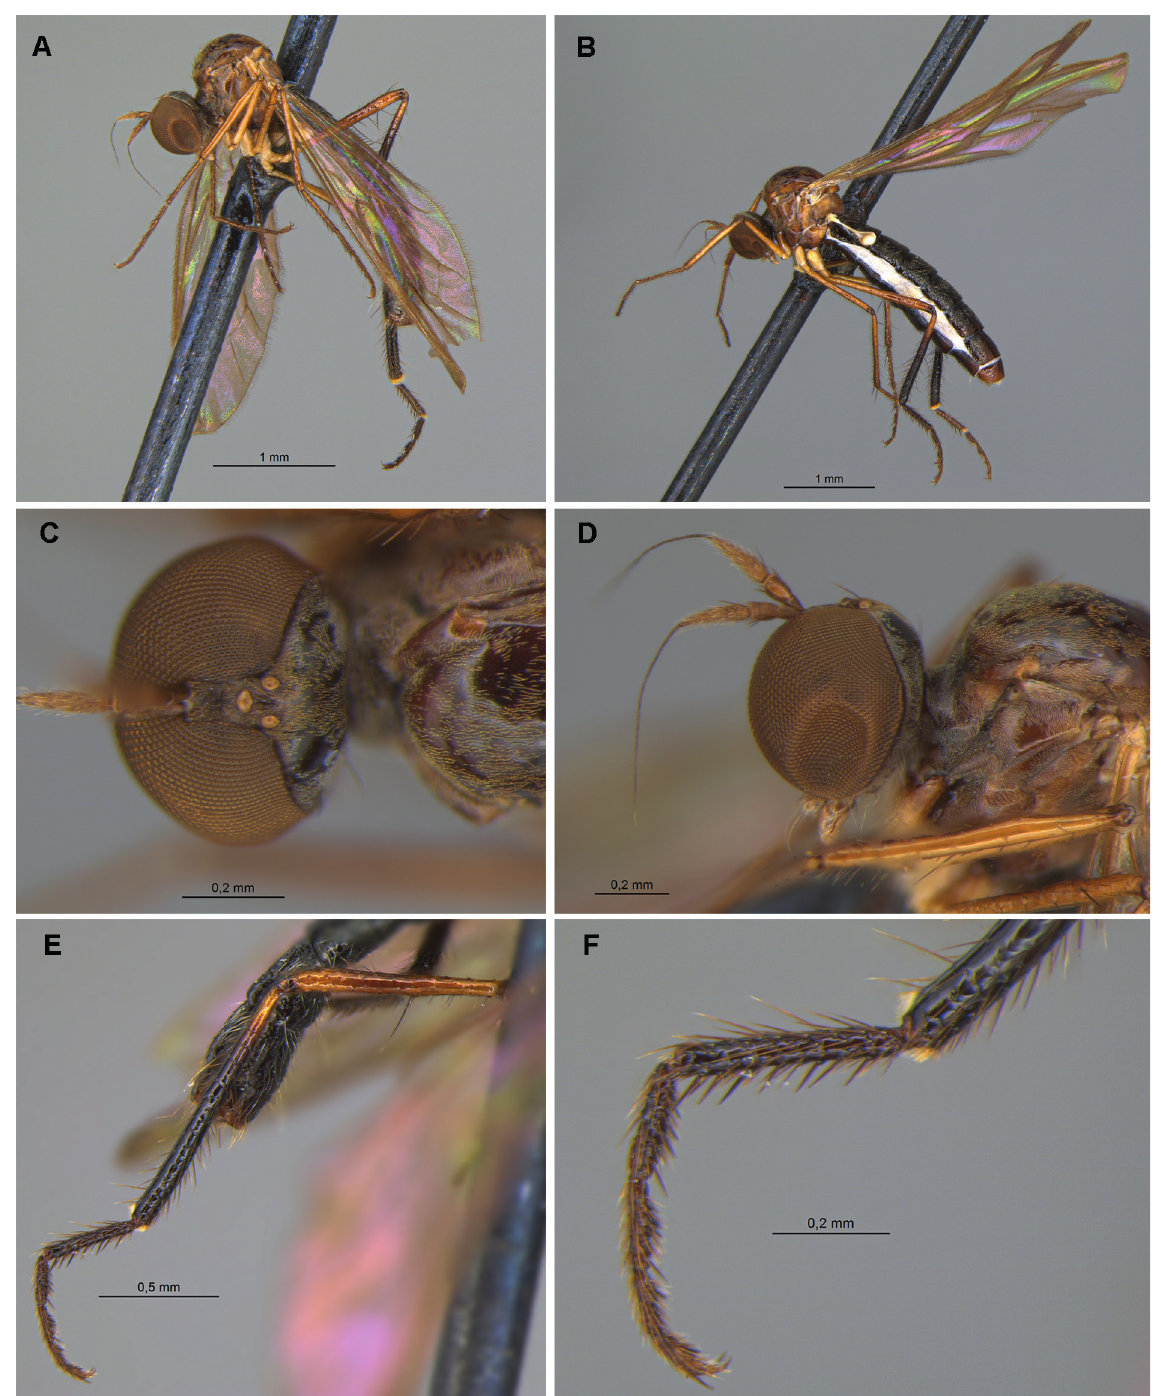
Fig. 1. Chvalaea australis sp. nov. A, C–F . ♂ , holotype (AMS). A . Habitus, lateral view. B . ♀, paratype (AMS), habitus, lateral view. C . Frons, dorsal view. D . Head, lateral view. E . Hind leg, lateral view. F . Hind tarsus, lateral